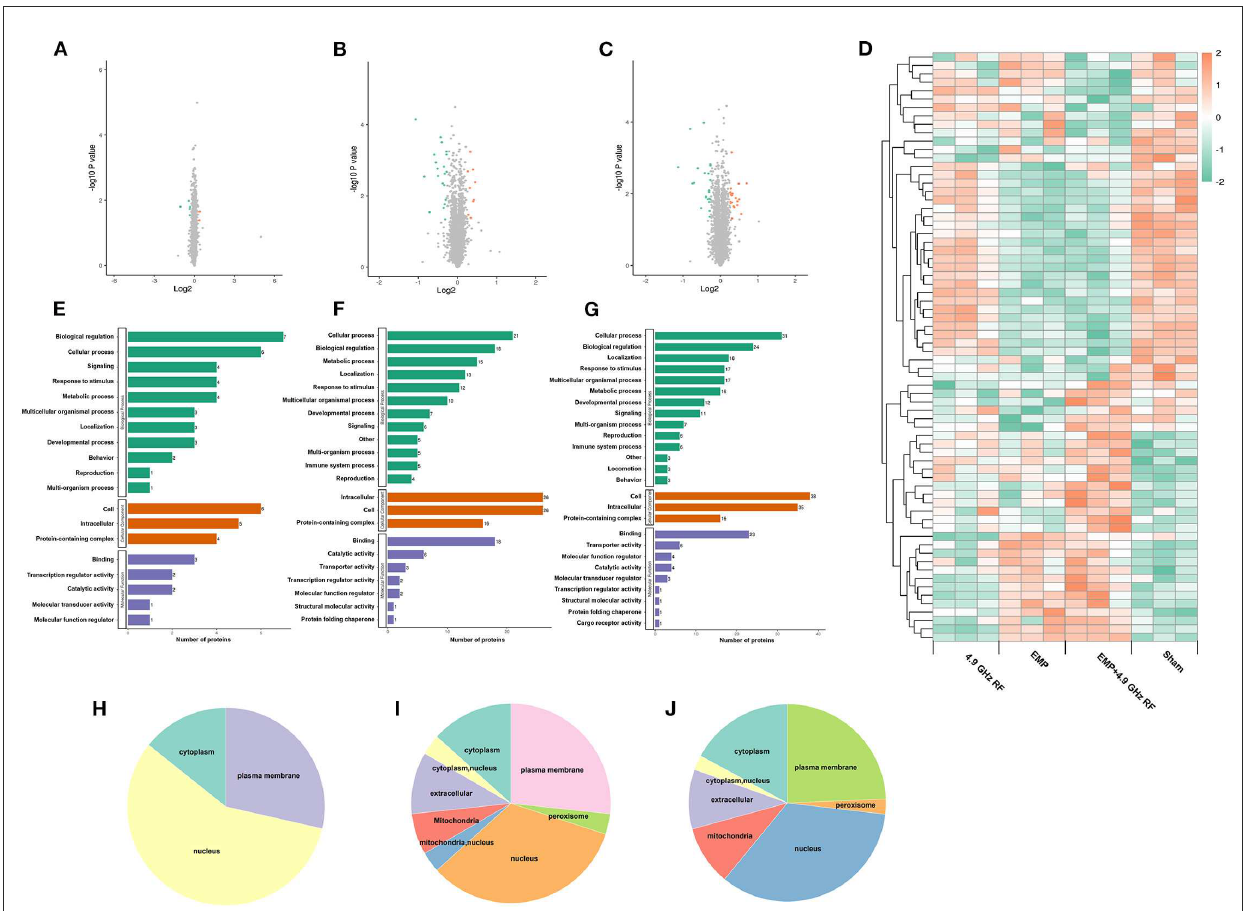
FIGURE3 Bioinformatics analysis of differentially expressed proteins. The volcano plot of DEPs in 4.9 GHz RF exposure group, EMP exposure group and combined exposure group (A–C) . Red points represent significantly up-regulated proteins and green points represent significantly down-regulated proteins. (D) Hierarchical clustering of DEPs in exposure groups and Sham group. GO enrichment analysis of DEPs in (E) 4.9 GHz RF exposure group; (F) EMP exposure group and (G) combined exposure group. (H) Subcellular localization prediction of 4.9 GHz RF exposure group; (I) EMP exposure group and (J) combined exposure